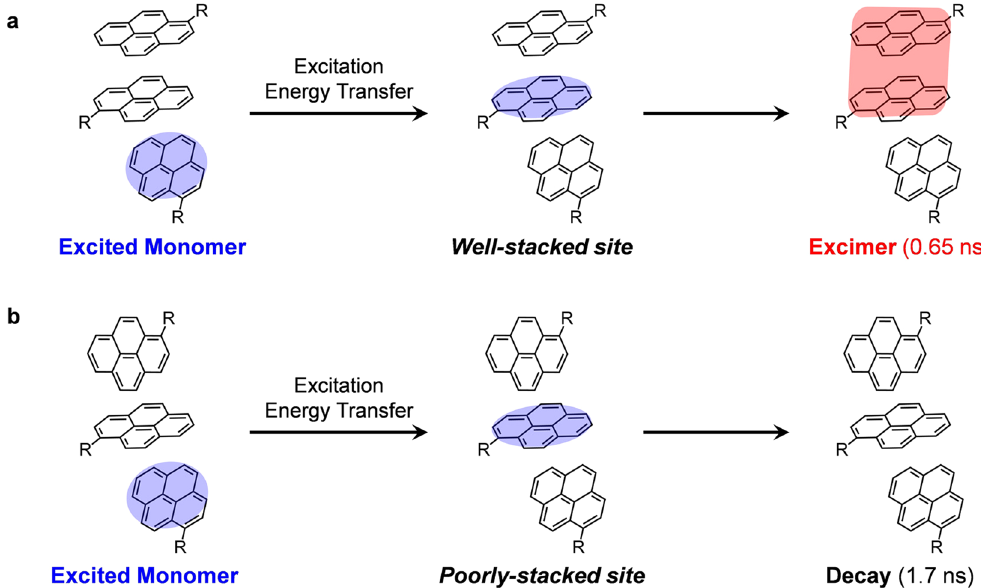
Figure 6. Mechanism for excitation energy transfer of liquid 1 . ( a ) A proposed diagram illustrating the formation an excimer from a ground-state monomer and its well-stacked excited-state monomer formed through excitation energy transfer (EET). ( b ) A proposed diagram illustrating the decay of an excited monomer without forming an